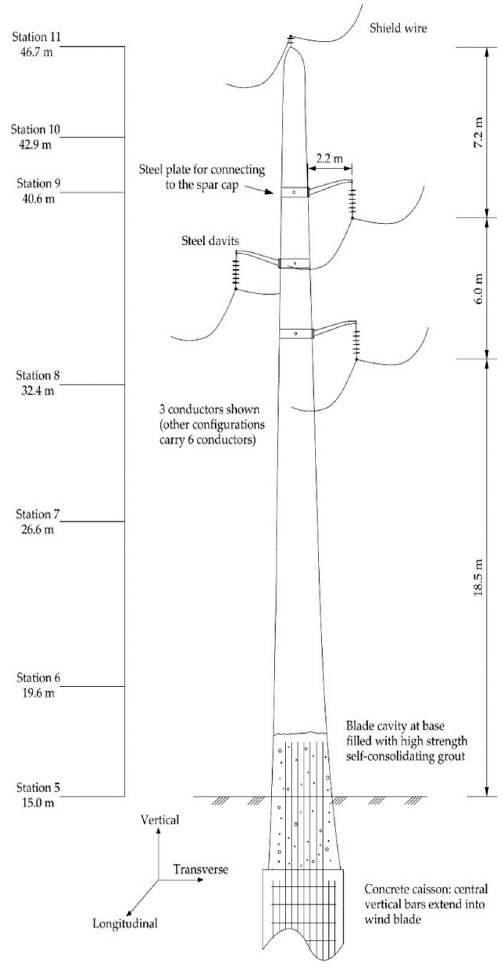
Figure A3. A clipper C96 blade configured as a tangent pole application [42].